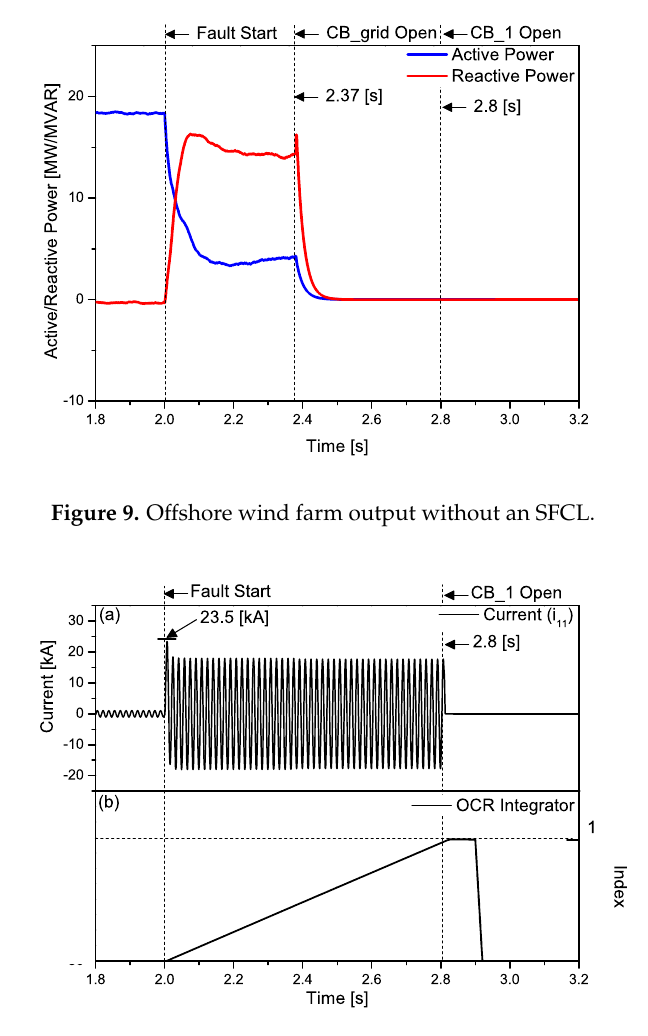
Figure 10. Feeder current ( i 11 ) and trip signal of OCR ( OCR 1 ) without an